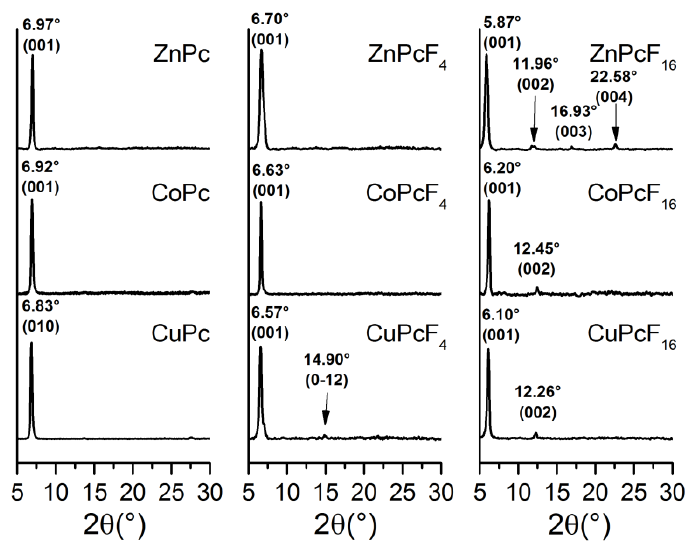
Figure 5. XRD patterns for thin film samples of MPcF x (M = Zn, Co, Cu; x = 0, 4, 16).